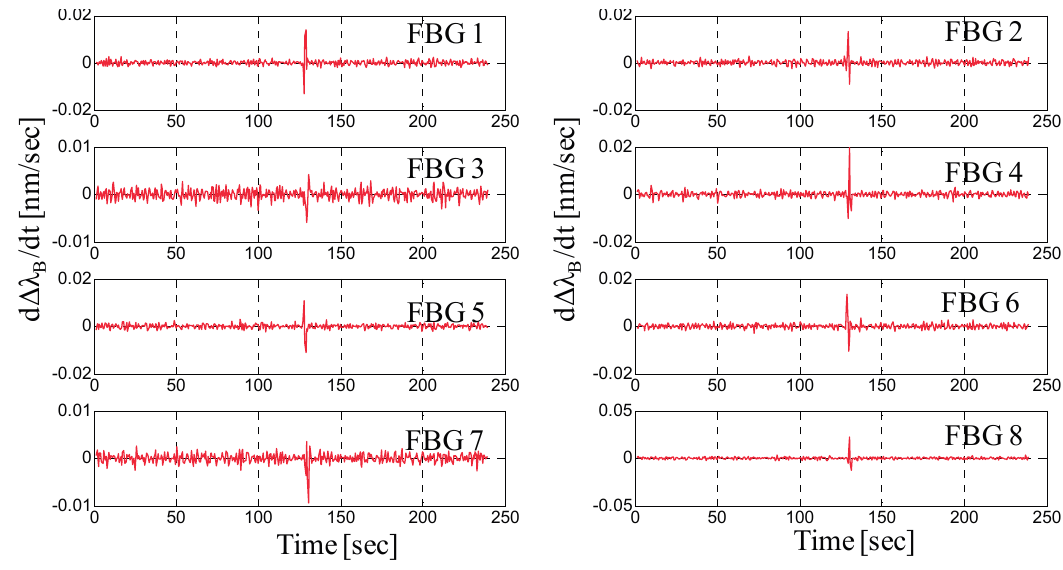
Figure 11. Derivative of the Bragg wavelength shift versus time for the eight